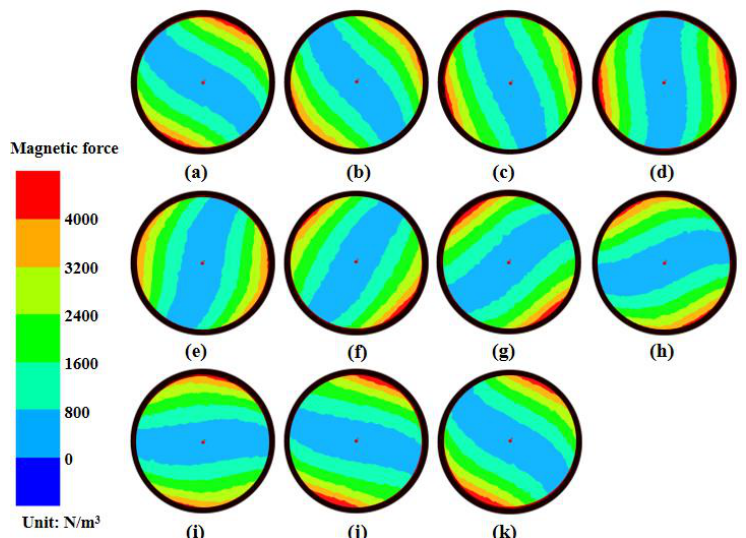
Figure 6. The transient distribution of the magnetic force with a solidified shell at different times of: ( a ) 0, ( b ) 1/20 T B , ( c ) 2/20 T B , ( d ) 3/20 T B , ( e ) 4/20 T B , ( f ) 5/20 T B , ( g ) 6/20 T B , ( h ) 7/20 T B , ( i ) 8/20 T B , ( j ) 9/20 T B , ( k ) 10/20 T B .